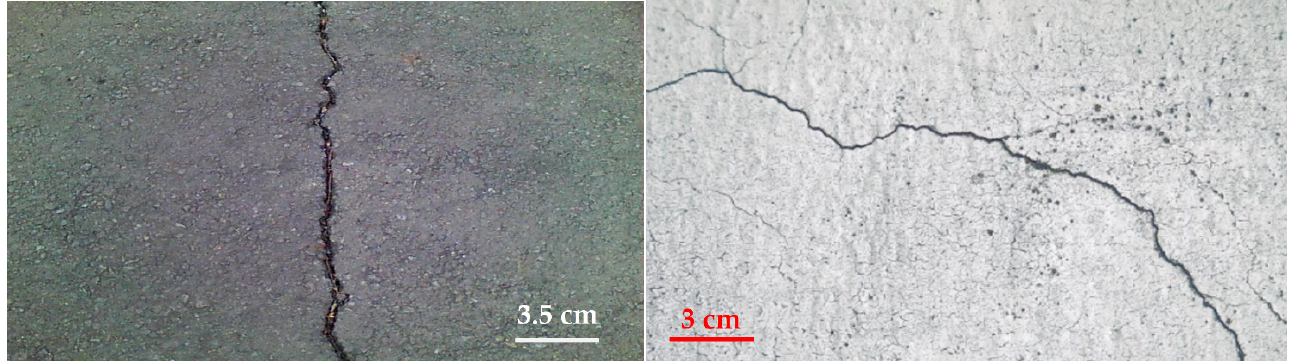
Figure 1. Sample images of concrete with surface crack defects.